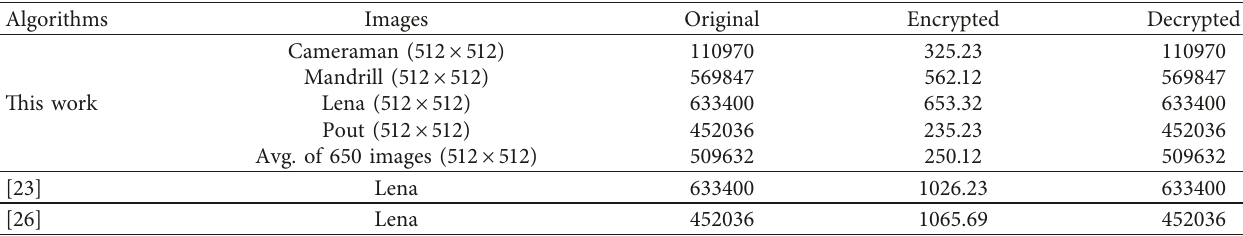
Table 3: Histogram variance.